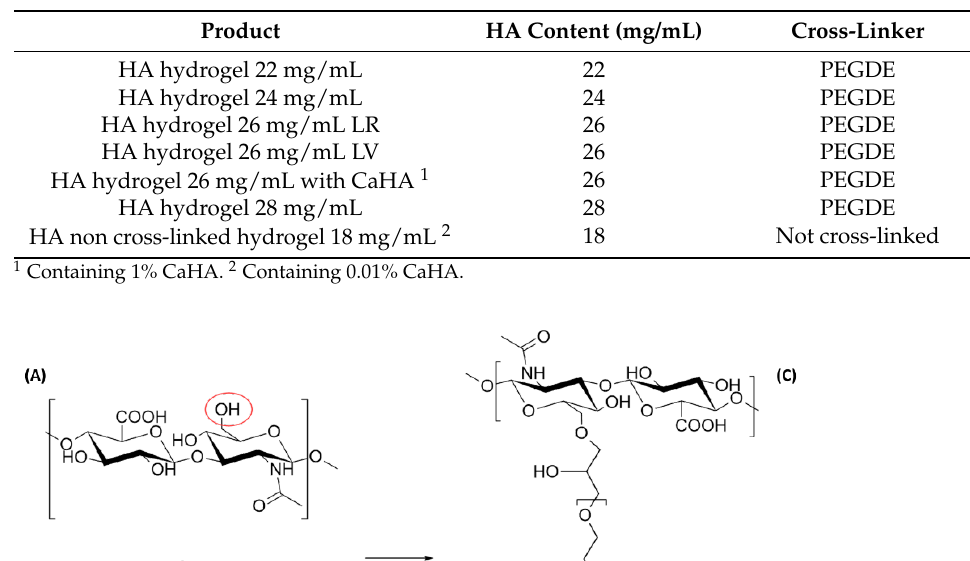
Table 1. Description of the seven HA hydrogel dermal fillers provided by Matex Lab S.p.A., which were collected to investigate their microscopic structure, rheological and cohesivity properties.